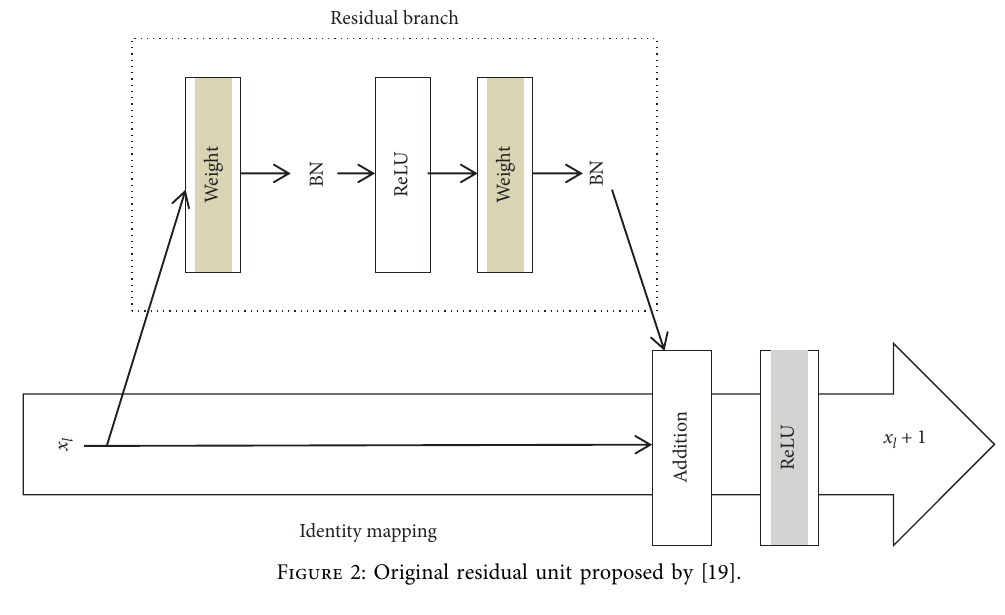
Figure 2: Original residual unit proposed by